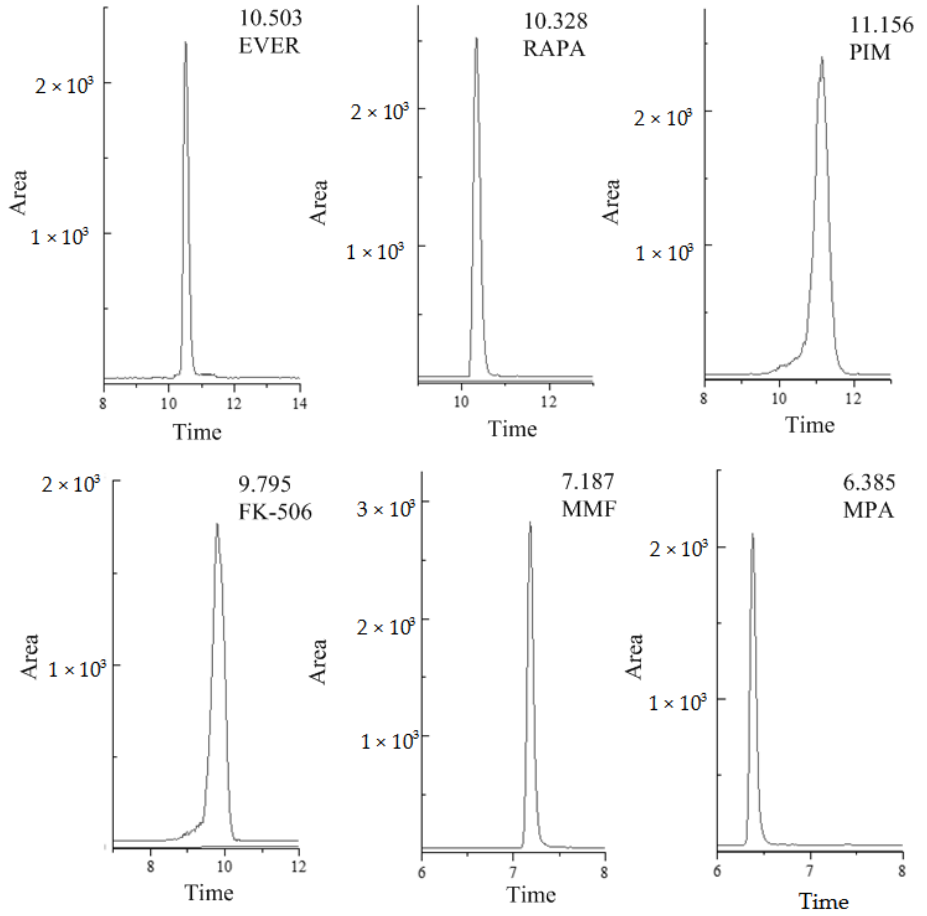
Figure 1. Typical selective ion chromatograms of blank plasma spiked reference compounds (FK- 506 and PIM at 100 ng · mL − 1 , RAPA and EVER at 500 ng · mL − 1 , MMF at 10 ng · mL − 1 and MPA at 1000 ng · mL − 1 ), (MPA = Mycophenolic acid, MMF = Mycophenolate Mofetil, FK-506 = Tacrolimus, RAPA = Rapamycin, EVER = Everolimus, PIM = Pimecrolimus).